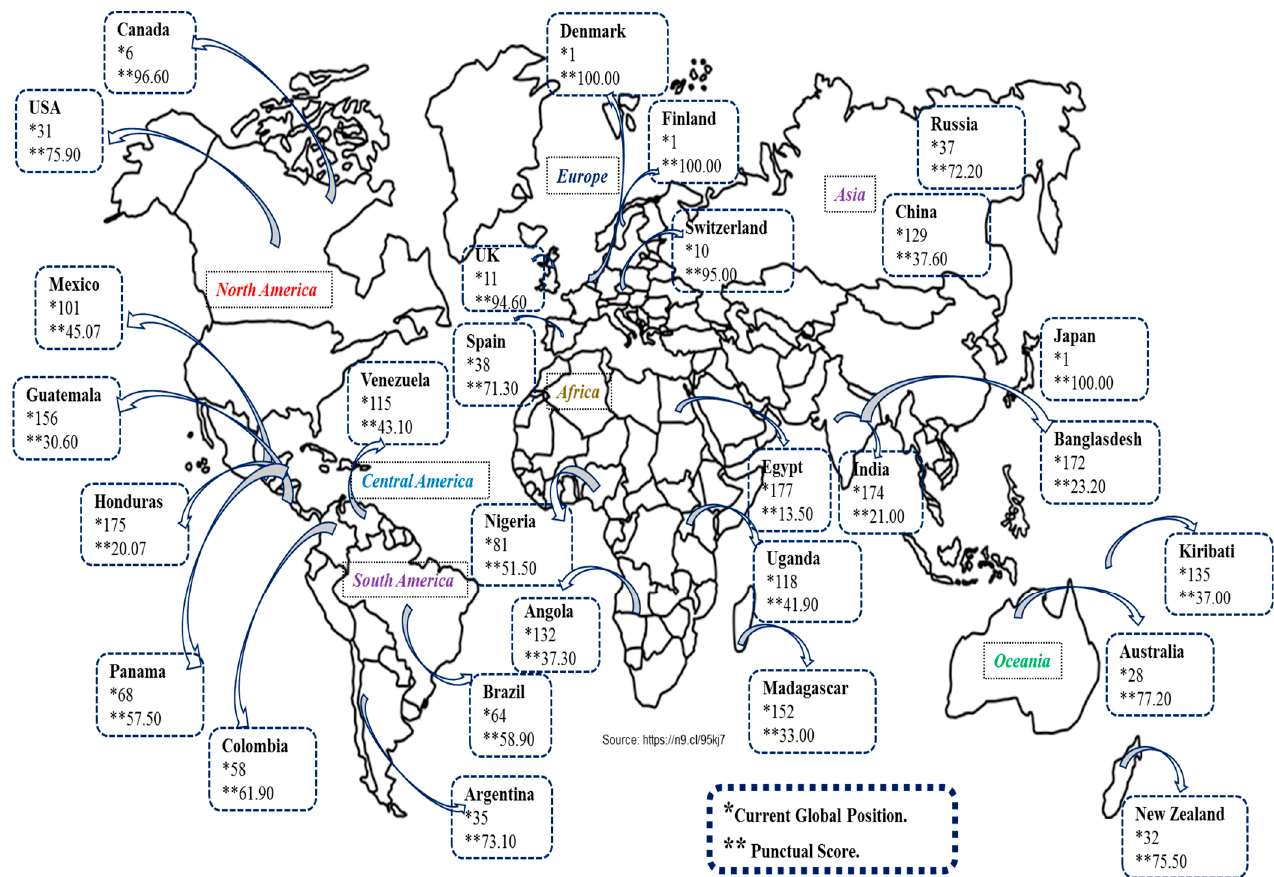
Figure 1. Environmental Performance Index (EPI) for Pb exposure in the category of heavy metals within the environmental health objective [2]. (Measure of lead exposure using age ‐ standardized number of disability ‐ adjusted life years (DALY) lost per 100,000 people due to this risk. Data on DALY rates of lead exposure come from the Health Metrics Institute and Assessment of the Global Burden of Disease Study (GBD), which is the most comprehensive global epidemiological study of lead exposure to date.)